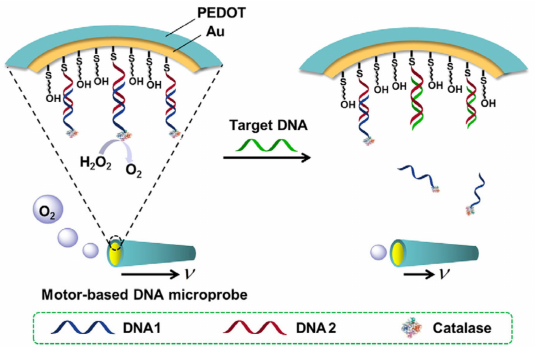
Figure 19. Schematic representation of motor-based microprobe for DNA detection via motion speed change. Reprinted with permission from ref. [210]. Copyright © 2016 Elsevier B.V.